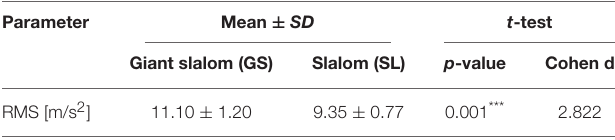
TABLE 1 | Descriptive and inferential statistics of the root-mean-square accelerations (RMS) that act on the lower back (i.e., sacrum sensor) in the competition disciplines giant slalom (GS) and slalom (SL). Parameter Mean ± SD t -test Giant slalom (GS) Slalom (SL) Cohen